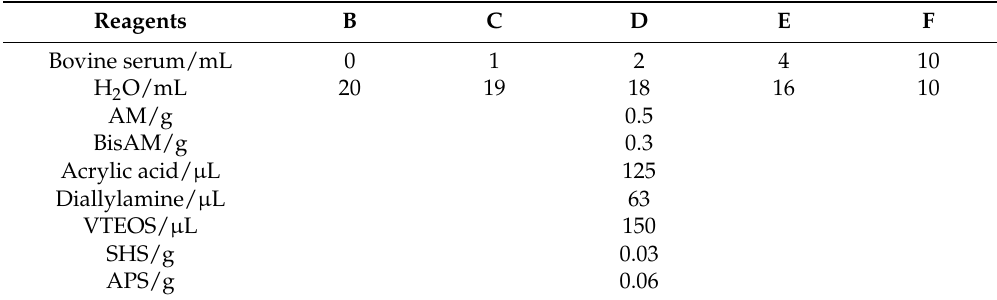
Table 1. Composition of the monomer